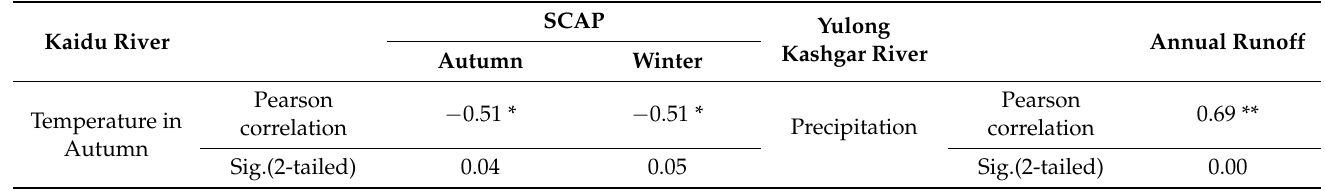
Table 5. Relationship between SCAP in autumn and winter and temperature in autumn in the Kaidu River, between annual runoff and precipitation in the Yulong Kashgar